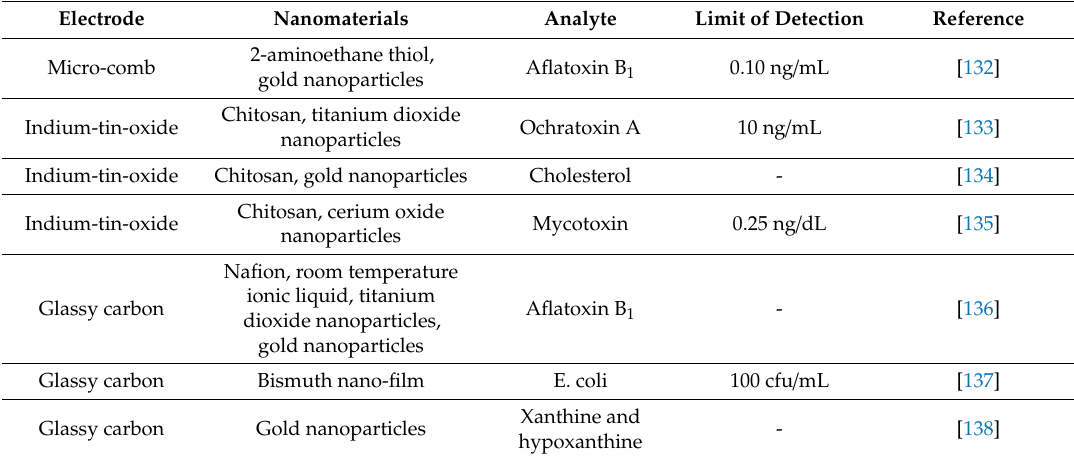
Table 7. Uses of nanomaterials to form biosensors for sensing the analyte found in food products